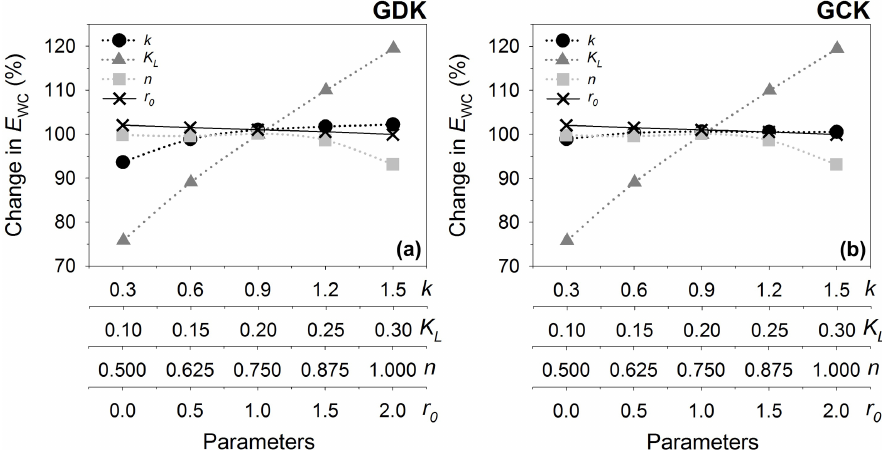
Figure B1. Sensitivity test of the wet canopy evaporation model to the parameters (i.e., k , K L , n , and r 0 ) .